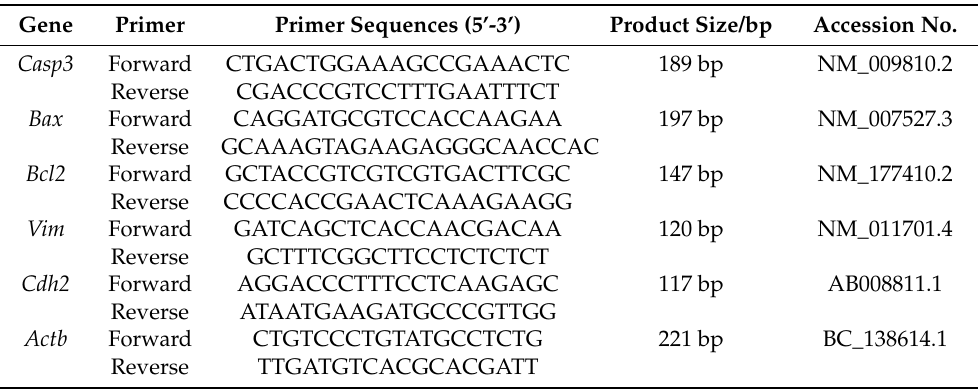
Table 5. Primers for real-time PCR